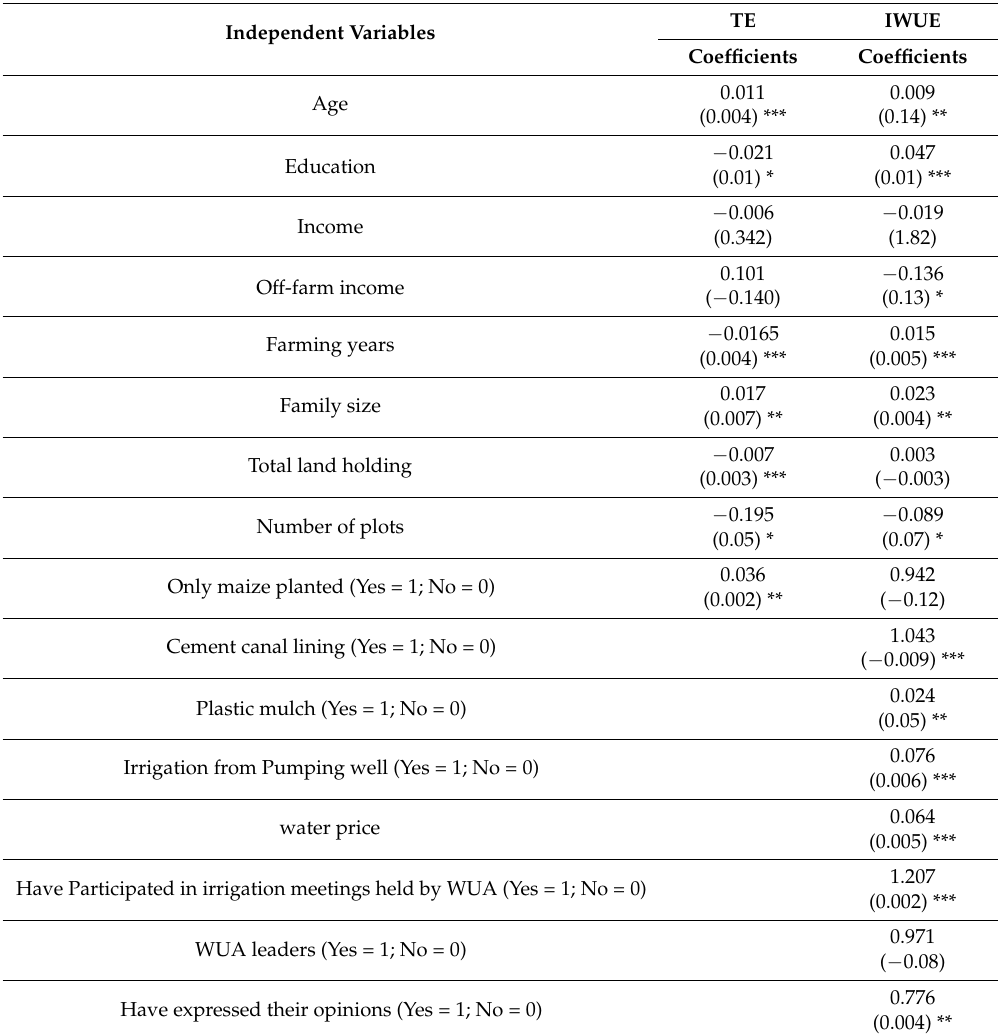
Table 5. Determinants of technical inefficiency and irrigation water use